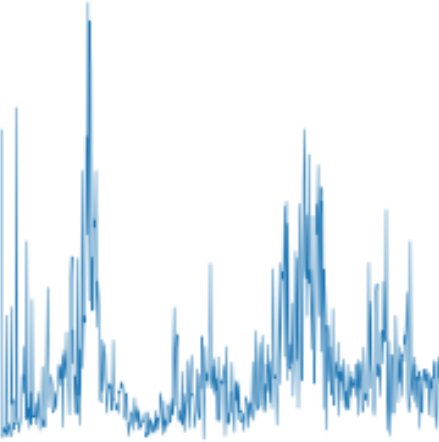
Figure 2. Image of FFT-based frequency-domain input (FD).